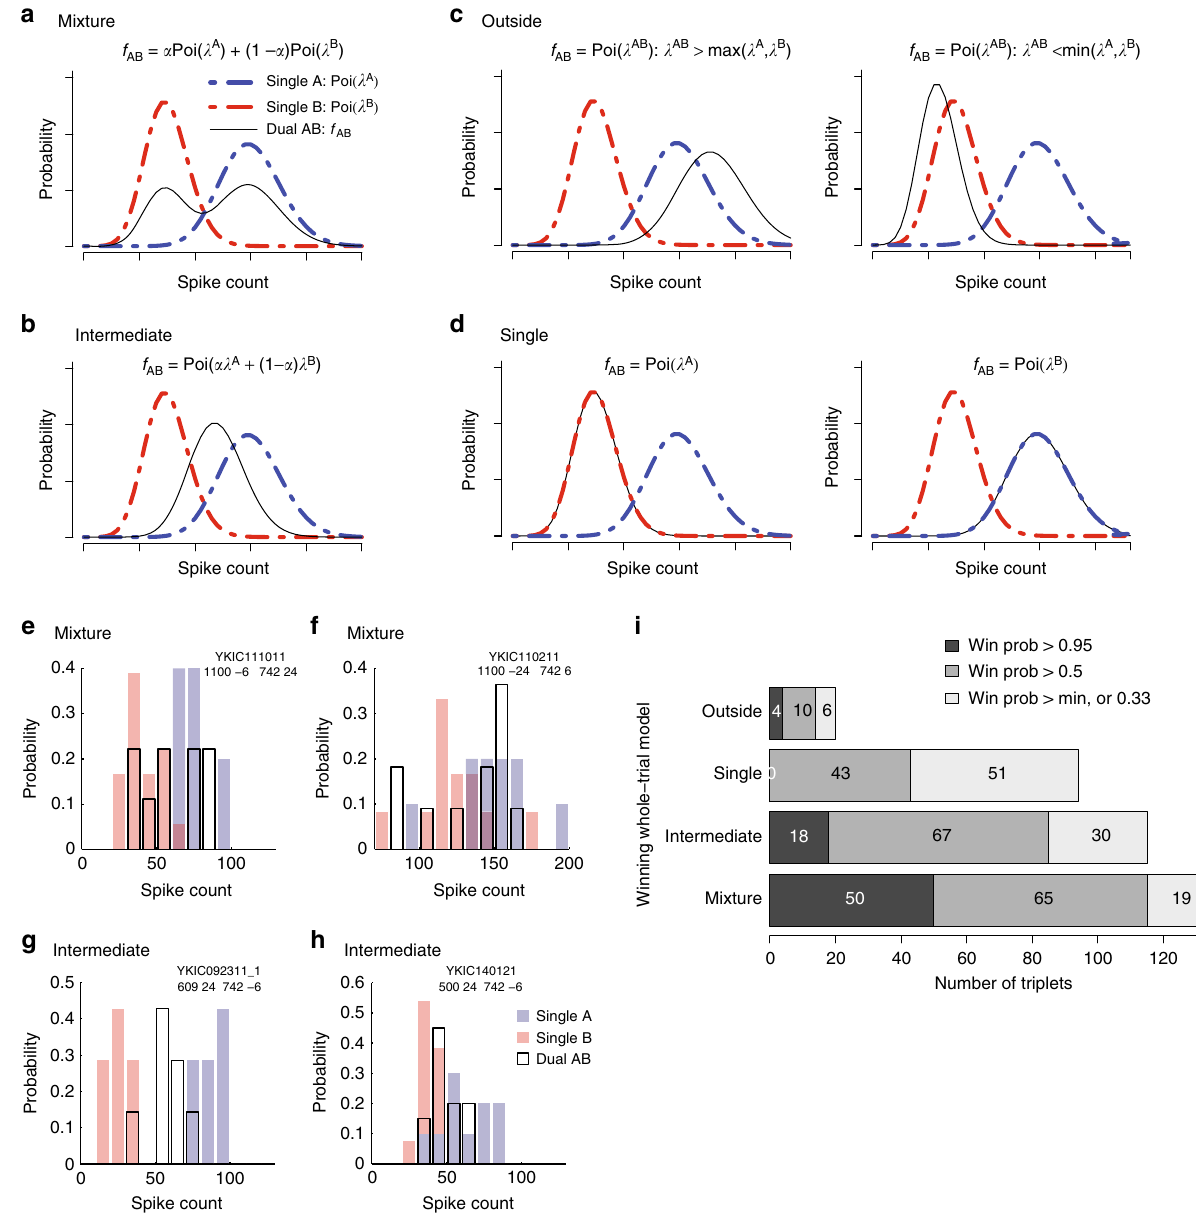
Fig. 2 Whole-trial analysis. a – d show the four models that could describe the distribution of spike counts on individual dual-sound trials (0 – 600 or 0 – 1000 ms after sound onset, see Methods). a Mixture of the Poisson distributions of spike counts for the component single-sound trials, b Intermediate Poisson distribution, with rate between the rates of single-sounds responses, c Outside, Poisson distribution with rate larger or lower than the rates of single- sounds responses, d Single, Poisson distribution with rate equal to one of the two single-sound rates. e – h Four examples of spike count distributions for triplets classi fi ed as Mixtures or Intermediates. Red and blue shades indicate distributions of spike counts for single-sounds; black outlines indicate distributions for dual sounds. The triplets in e , f were classi fi ed as Mixture with winning probability > 0.95 ( e shows the same triplet as Fig. 1e; f shows the same triplet as Fig. 3b). Triplets in g , h were classi fi ed as Intermediate with winning probability > 0.95 ( g shows the same triplet as Fig. 1f and Fig. 3c; h shows the same triplet as Fig. 3d). i Population results of the whole-trial analysis. Shading indicates the con fi dence level of the assignment of